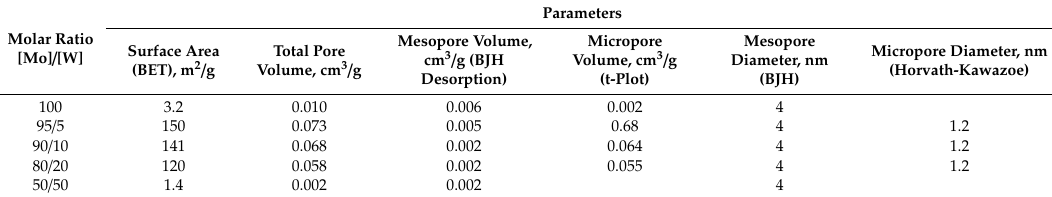
Table 1. Porous structure of molybdenum-tungsten carbides calcined at 900 ◦ C in inert atmosphere ([R] / [Me] =